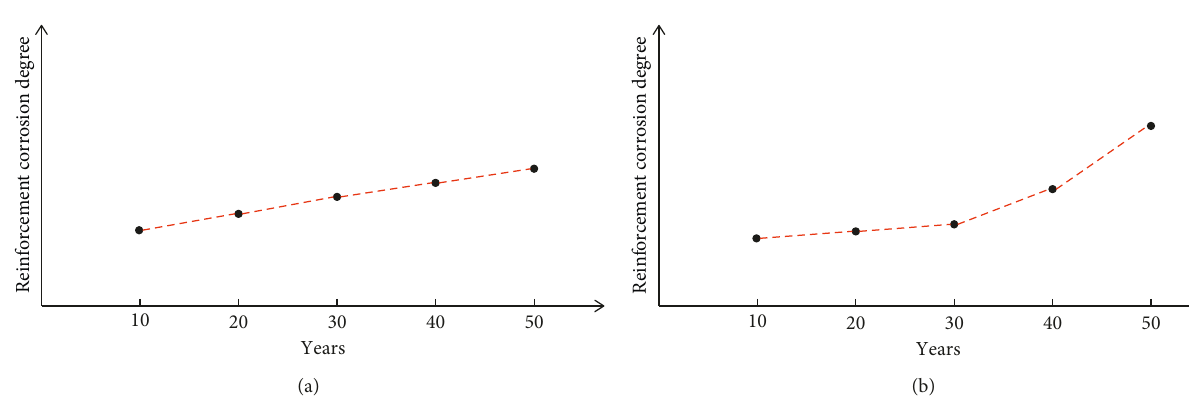
Figure 1: The variation trend of inspection